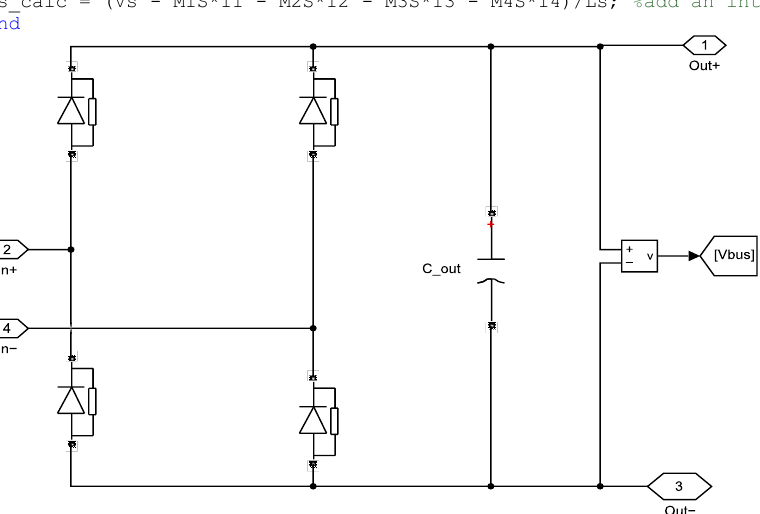
Energies 2022 , 15 , x FOR PEER REVIEW Figure A5. The following rectifier is used on the secondary side. Figure A5. The following rectifier is used on the secondary side.